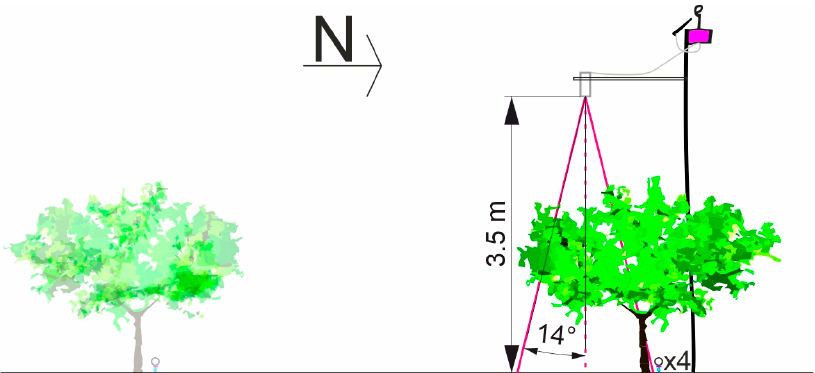
Figure (cid:561) 12. (cid:561) The (cid:561) canopy (cid:561) infrared (cid:561) radiometer (cid:561) sensor (cid:561) placement. (cid:561) Figure 12. The canopy infrared radiometer sensor